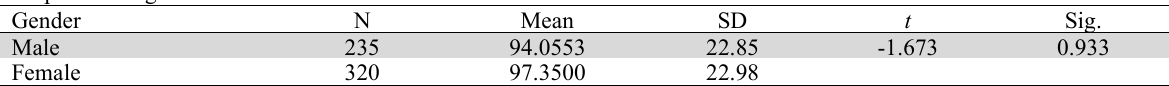
Comparison of gender for FWB